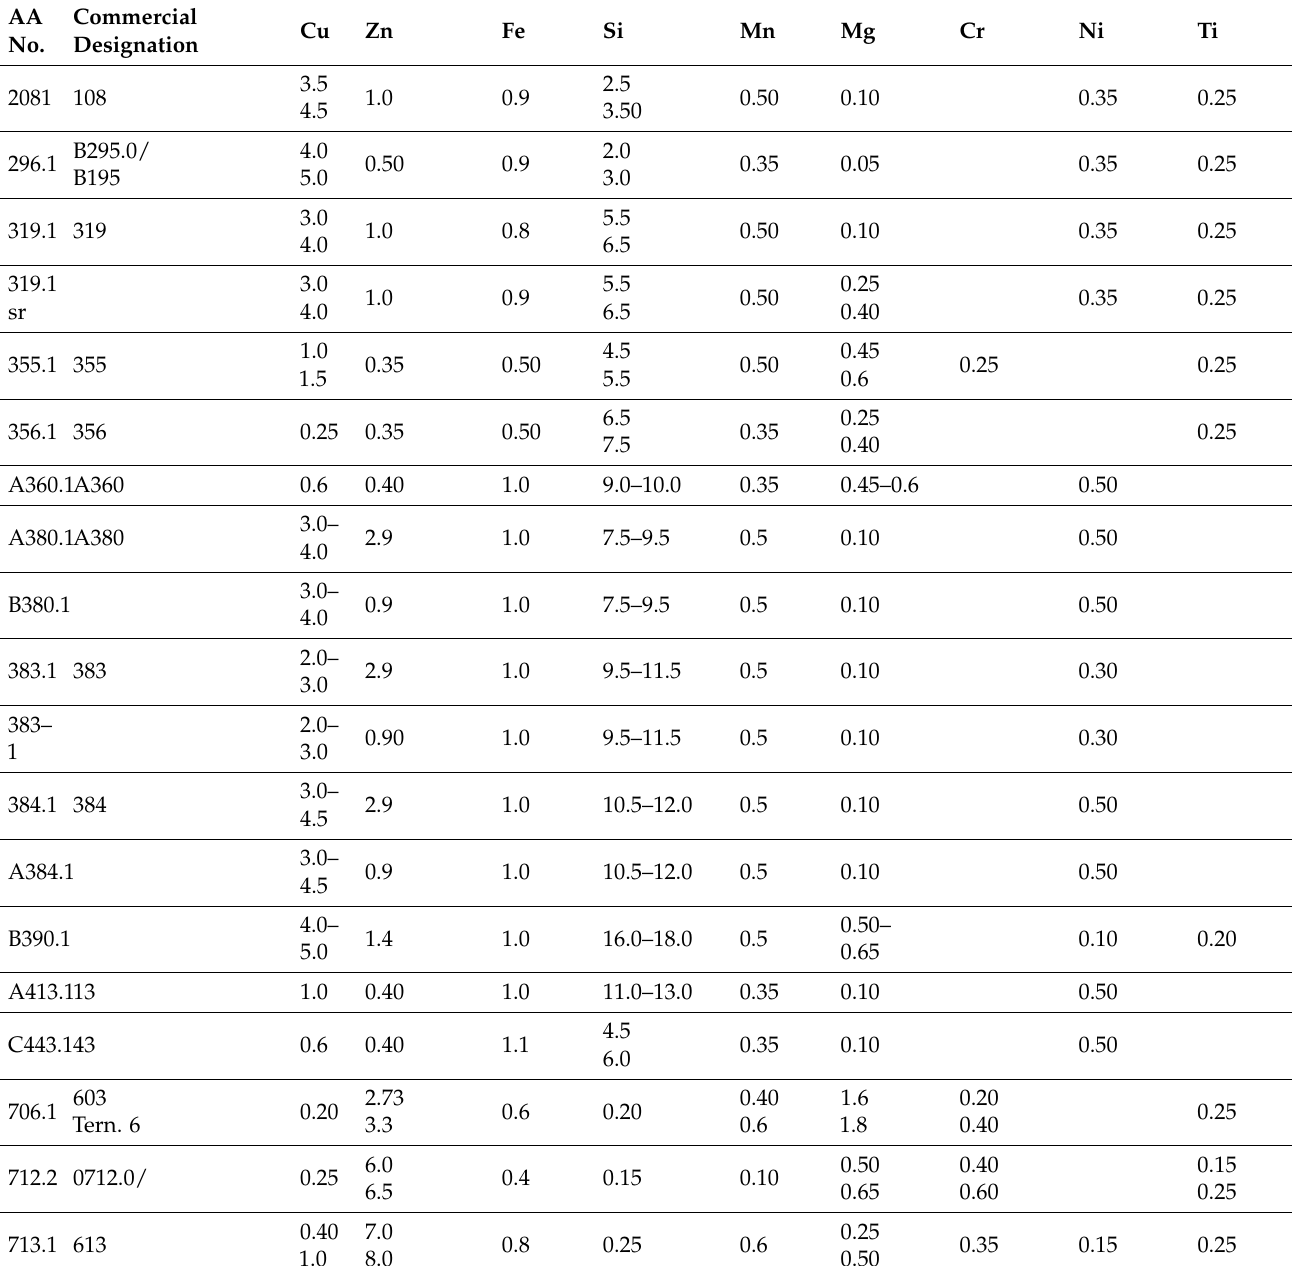
Table 1. Chemistry of common secondary alloys (adapted after